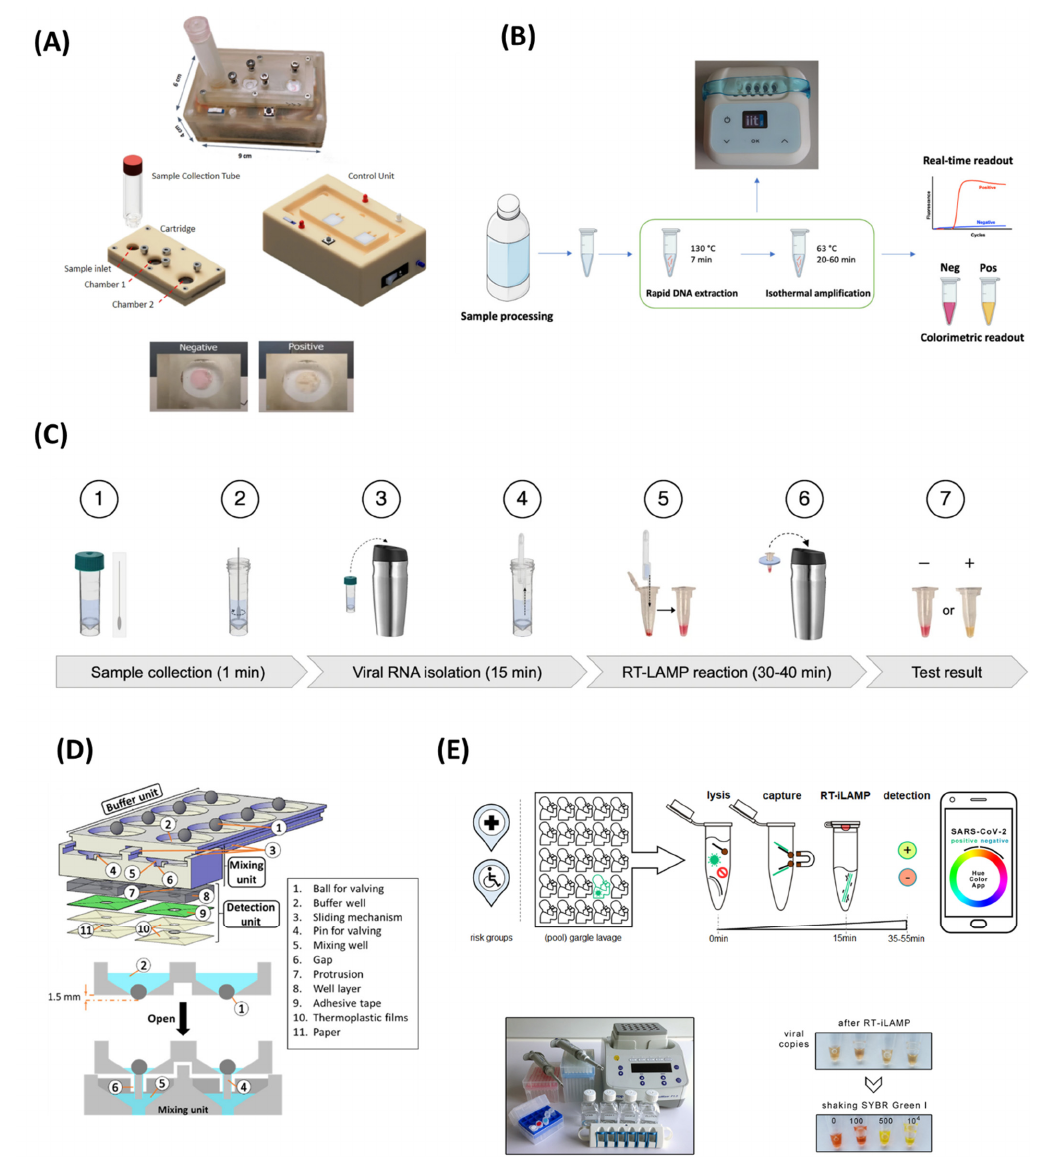
Figure 2. LAMP-based biosensors using dye detection. ( A ) A self-contained device diagnosis of SARS-CoV-2 virus with a disposable cartridge and an Arduino-based reusable microcontrolling unit. ( B ) Schematic representation of Clostridium tyrobutyricum in milk at POC. ( C ) Illustration of a thermos-based home test for COVID-19. ( D ) Polycarbonate POC testing device with a ball-based valve system for sample delivery and reagent preparation. ( E ) Workflow of Cap-iLAMP. Reproduced with permission from references [49,51,53,60,61]. Copyright 2021 and 2022 Springer Nature, 2021 American Chemical Society, 2021 MDPI.